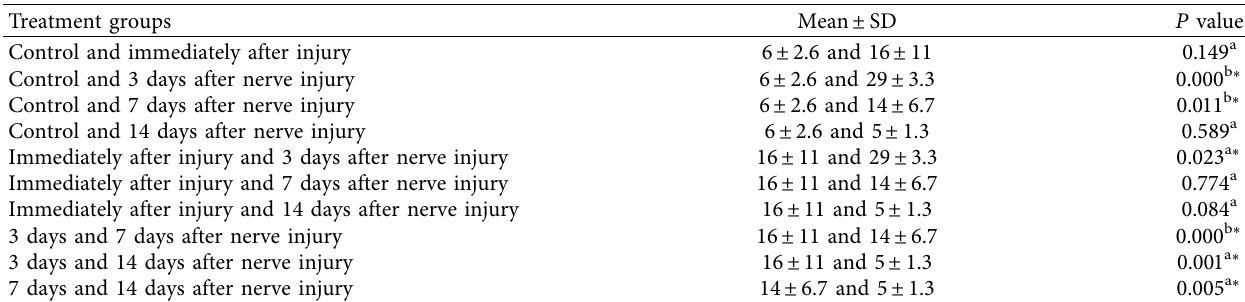
Table 2: Post hoc analysis comparing various groups of treatment with respect to inflammation cells found on histopathologic analysis. Treatment groups Mean ± SD Control and immediately after